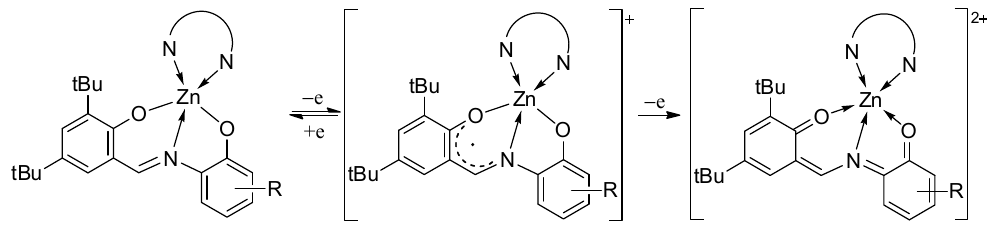
Scheme 3. Two successive electrochemical oxidation stages for complexes 1 – 3 , 5 , and 8 .